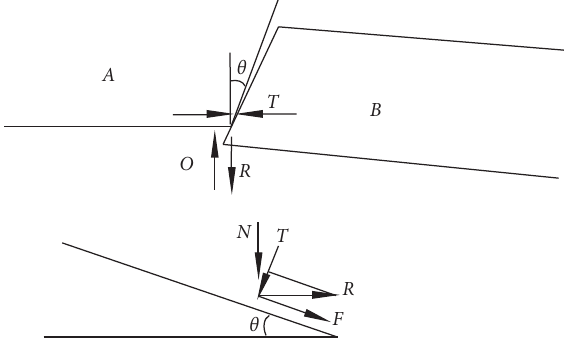
Figure 3: The mechanical model of the roof